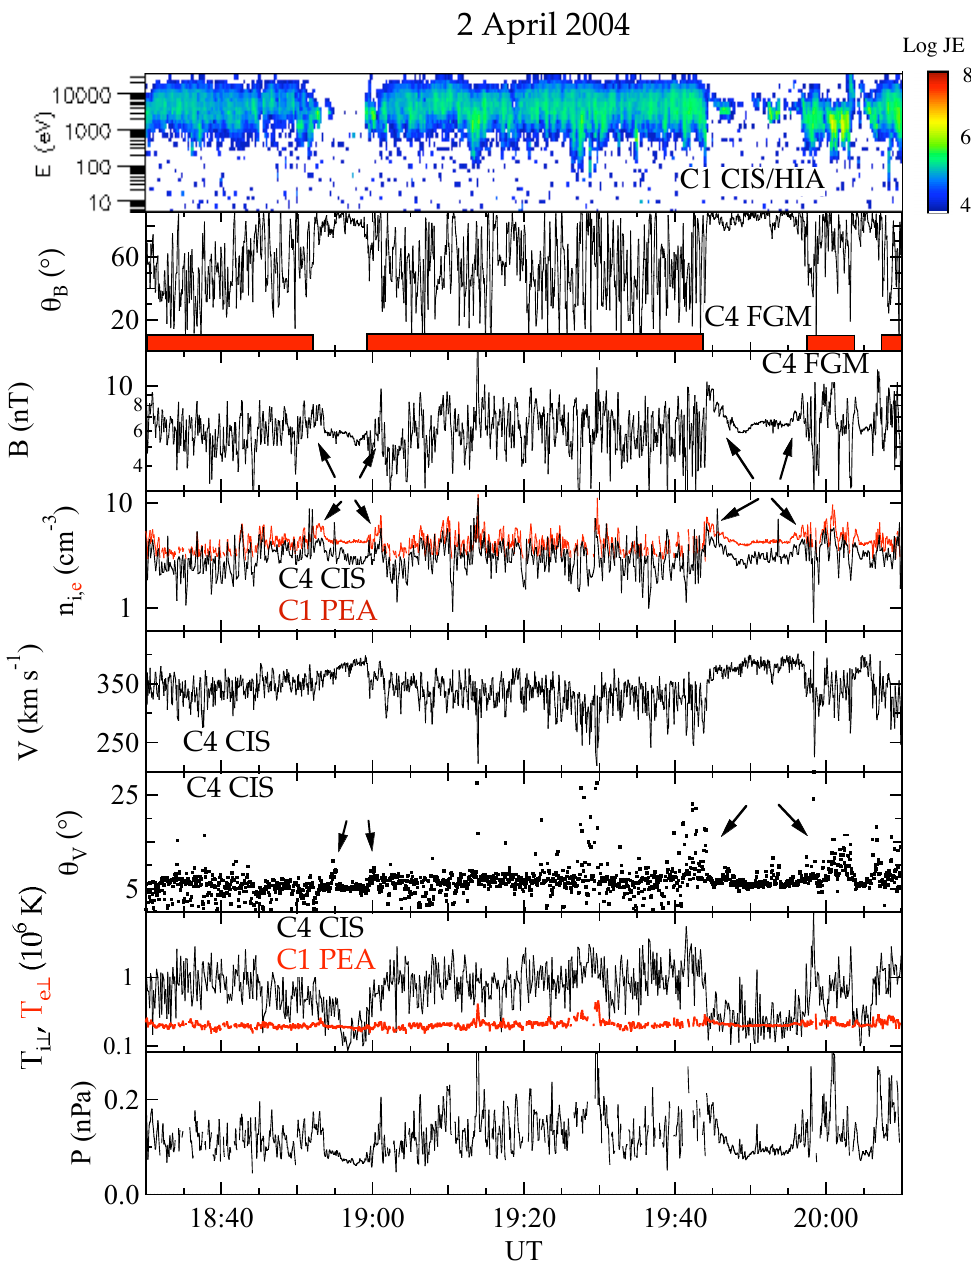
Fig. 4. Cluster-1 and -4 plasma and magnetic field observations from 18:30 to 20:10UT on 2 April 2004. From top to bottom, the figure displays the CIS/HIA ion energy flux (keVcm 2 s − 1 kev − 1 ) arriving at the spacecraft from the full range of meridional look directions and the azimuthal quadrant centered on the antisunward look direction, the cone angle ( θ B ) between the IMF and the Sun-Earth line, the total magnetic field strength, the PEACE electron (red) and CIS/CODIF ion (black) densities, the CIS/CODIF ion flow velocity, the cone angle θ V between the CIS/CODIF ion velocity and the Sun-Earth line, the PEACE electron (red) and CIS/CODIF ion (black) temperatures, and the total pressure (sum of the magnetic, CIS/CODIF ion thermal, and PEACE electron thermal temperatures). Horizontal red bars in the cone angle panel indicate foreshock intervals marked by low cone angles, enhanced suprathermal ion energy fluxes, depressed plasma flow velocities, and enhanced wave activity. Arrows indicate enhanced magnetic field strengths and densities, and flow deflections, on the edges of the foreshock. Here CIS: Cluster Ion Spectrometry, HIA: Hot Ion Analyzer, CODIF: Composition Distribution Function, PEACE: Plasma Electron and Current Experiment, and FGM: fluxgate